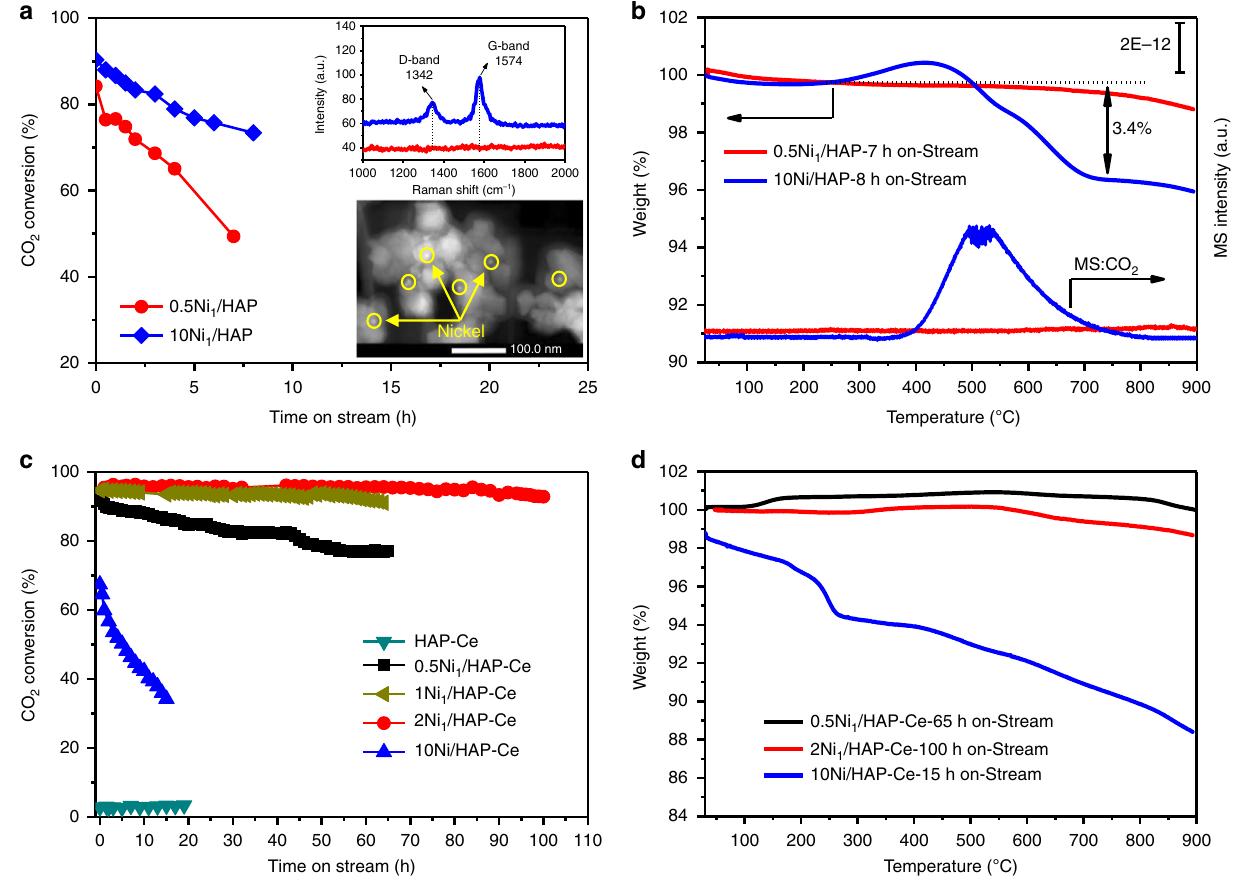
Fig. 4 DRM performance and carbon deposition analysis over Ni/HAP and Ni/HAP-Ce samples. a CO 2 conversion during DRM over HAP and c HAP-Ce supported different Ni catalysts. Conditions: T = 750 °C, CH 4 /CO 2 /He = 10/10/30, total fl ow = 50 mL min – 1 (GHSV = 60,000 mLh − 1 g cat − 1 ), inset is Raman spectra of spent 0.5Ni 1 /HAP and 10Ni/HAP after reaction at 750 °C and STEM image of 0.5Ni 1 /HAP after 7 h reaction; b – d TGA-MS and TGA pro fi les of various catalysts after different reaction times on-stream at 750